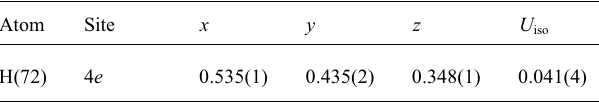
Table 2. Atomic coordinates and displacement parameters (in Å 2 ) .